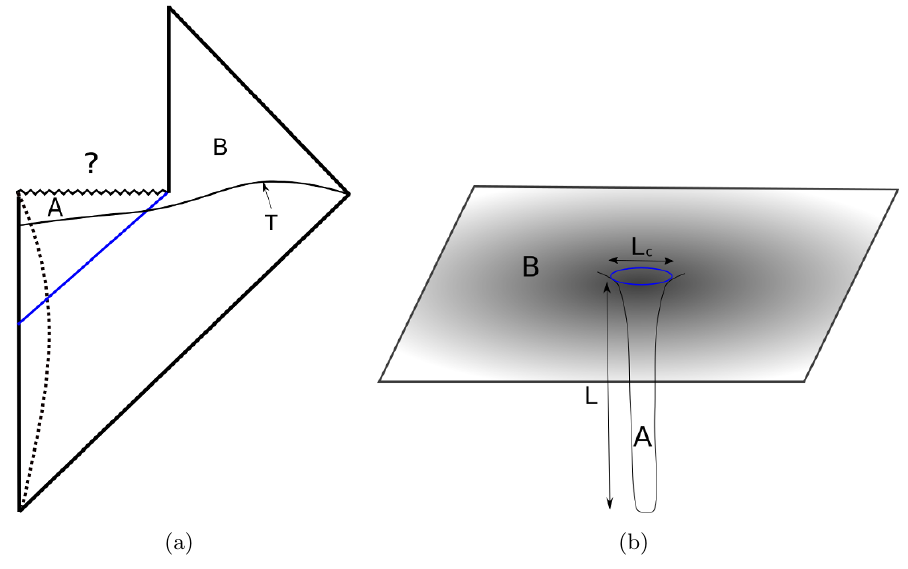
Figure 17 . (a) The Penrose diagram of an evaporating black hole. The question mark is intended to represent the unknown fate of the interior of the black hole. (b) The geometry for the quantum state at t = T . When the size of the horizon is l c , the region inside the horizon is stretched to a long funnel with size L (cid:24) M 7 = 2 (cid:20) 5 l (cid:0) 1 = 2 c